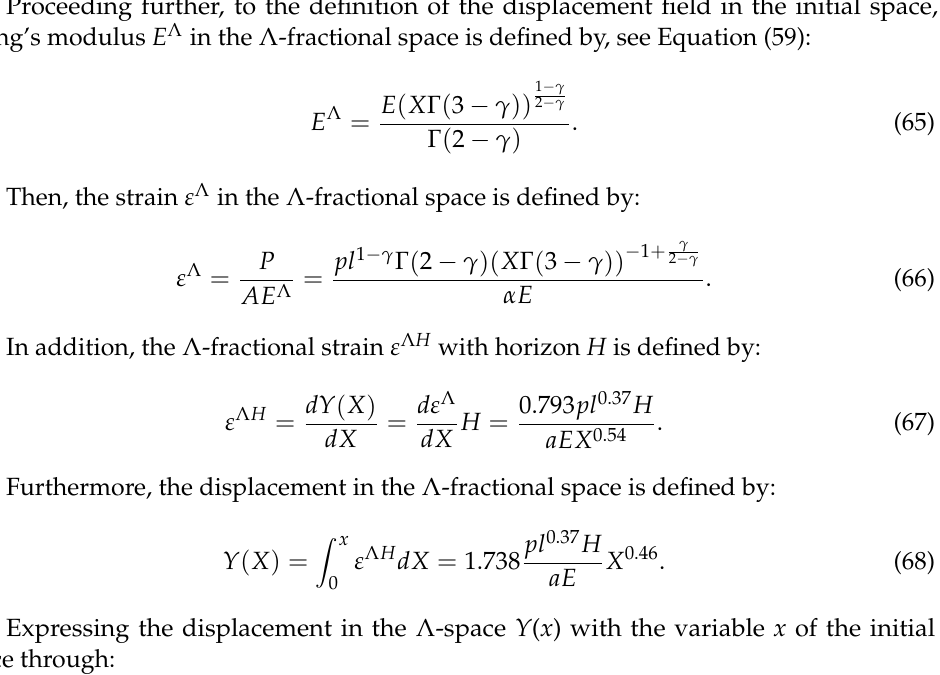
Figure 25. The average left and right fractional stresses in the initial space with a horizon.